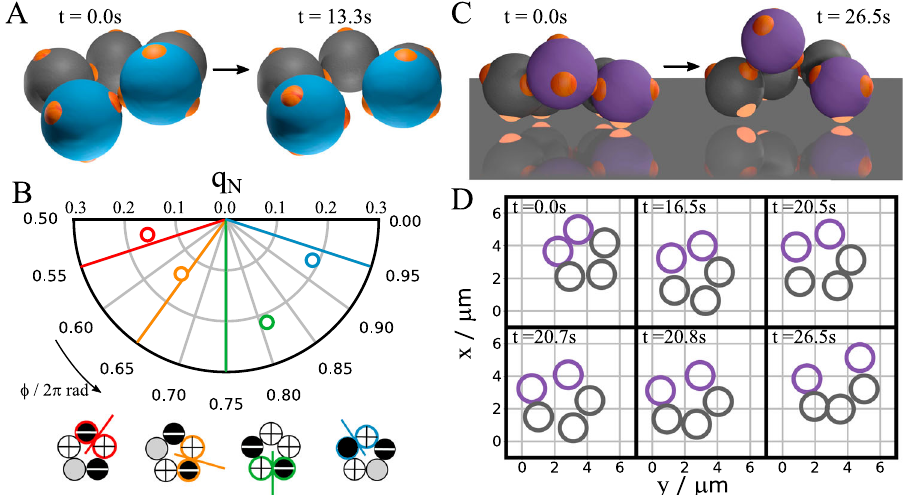
Fig. 4 Colloidal cyclopentane ring-opening reaction. A , B Thermal ring-opening of free colloidal cyclopentane. A Three-dimensional reconstruction of a dissociating ring just before (left) and just after breaking the bond between the blue particles (right). Particle diameter is 3.7 μ m. B Top: examples of ring con fi gurations just before breaking (circles) and corresponding breaking points (radial lines) in q – ϕ space. Bottom: breaking points in schematic representation, with colours indicating braking position. Colour coding matches the q – ϕ coordinates above. C , D Catalytic ring-opening of colloidal cyclopentane on an attractive (hydrophobic) surface. C Three-dimensional reconstruction of the ring shown before (left) and after breaking the bond between the purple particles (right). The bright patches are attached to the surface. D Time sequence of the surface diffusion and eventual breaking of the bond between the purple particles of the surface-bound